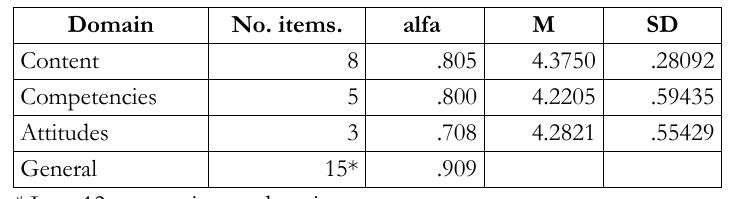
Table 3. Overall reliability analysis and stratified according to domain of CAPABP ( N = 39)